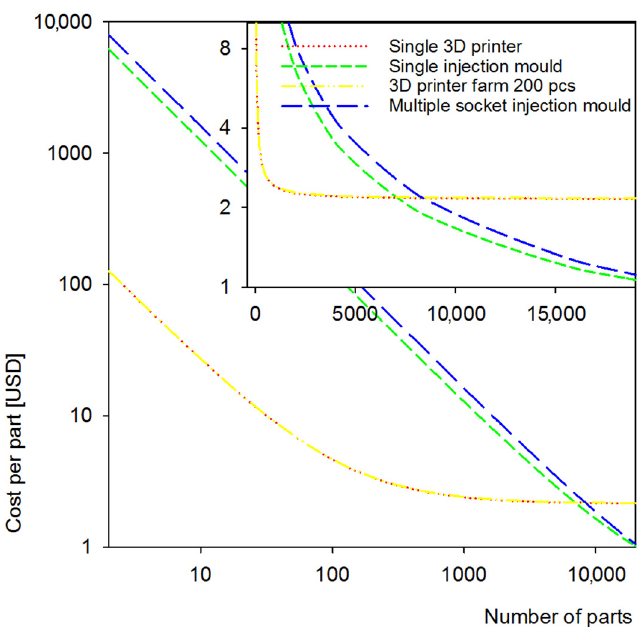
Figure 4. Cost comparison of manufacturing an element depending on the production volume for various manufacturing techniques.